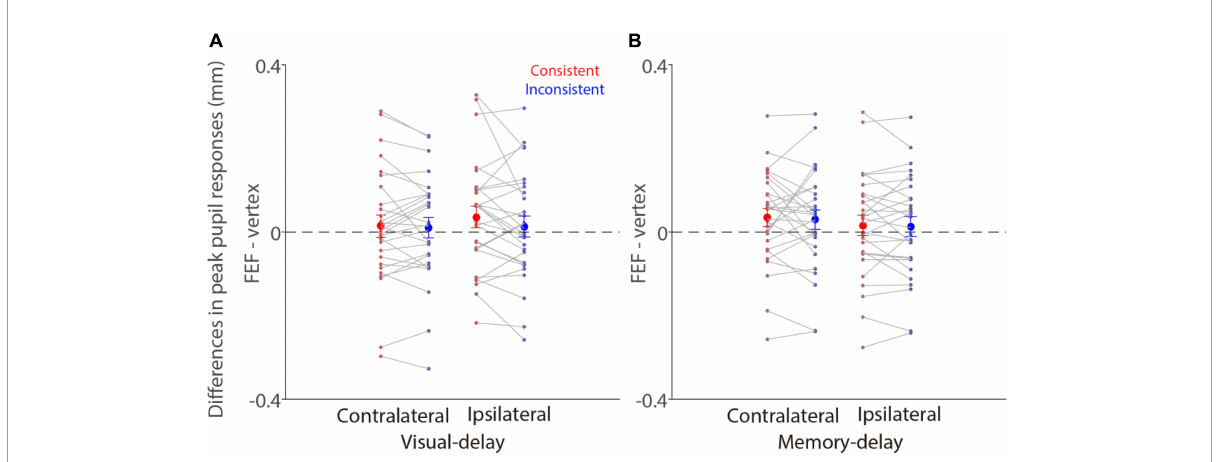
FIGURE6 Effects of FEF cTBS between FEF and vertex stimulation conditions. (A) Differences in mean values of pupil peak responses (peak epoch: 600–700 ms after patch onset) between FEF and vertex stimulation (FEF minus vertex) in the visual-delay task ( N = 28). (B) Differences in mean values of pupil peak responses (peak epoch: 600–700 ms after patch onset) between FEF and vertex stimulation (FEF minus vertex) in the memory-delay task ( N = 28). The large-circle and error-bars represent the mean values ± standard error across participants. The dots represent mean value for each participant. Contralateral: contralateral stimulus condition (left). Ipsilateral: ipsilateral stimulus condition